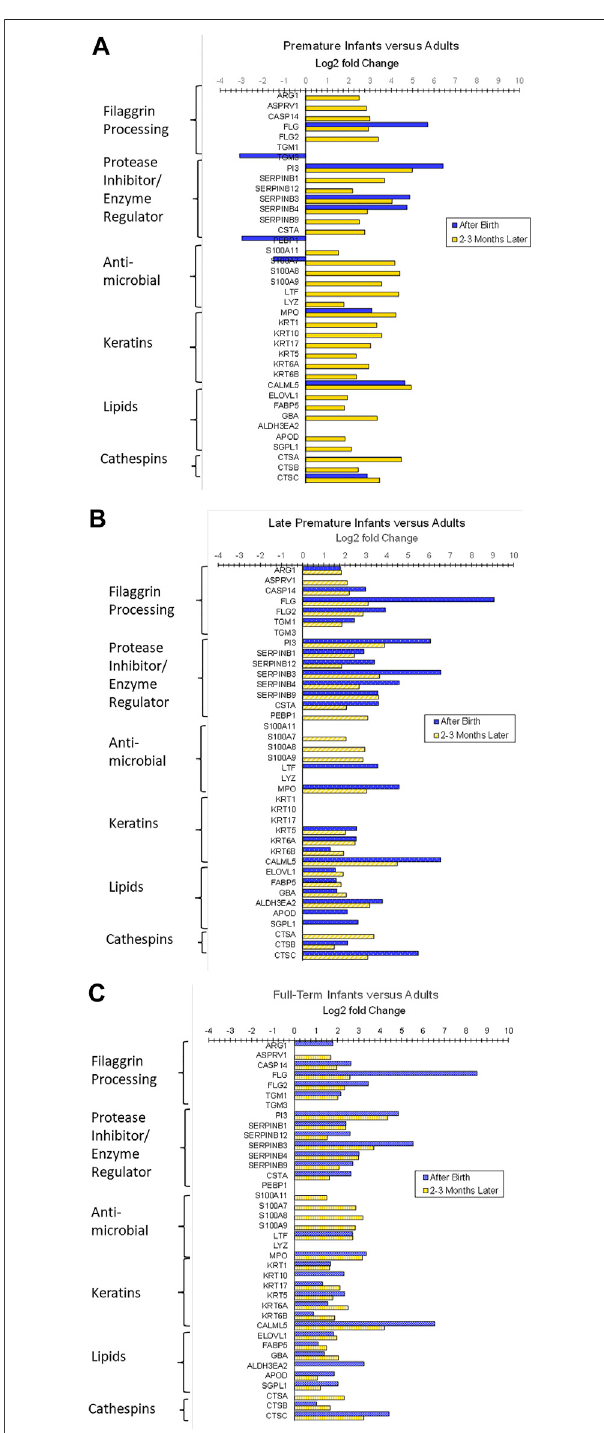
FIGURE4| Differentiallyexpressedbiomarkersforinfants4 – 8 daysafter birth and 2 – 3 months later at corrected GAs of 46 – 48 weeks versus adult skin. Two sequential skin surface samples (stratum corneum) were collected fromthelowerlegsof61infantsateachtimeandfromthevolarforearms of 34 adults (parent) at one time. Samples were extracted, quanti fi ed with liquid chromatography tandem mass spectrometry, and analyzed with